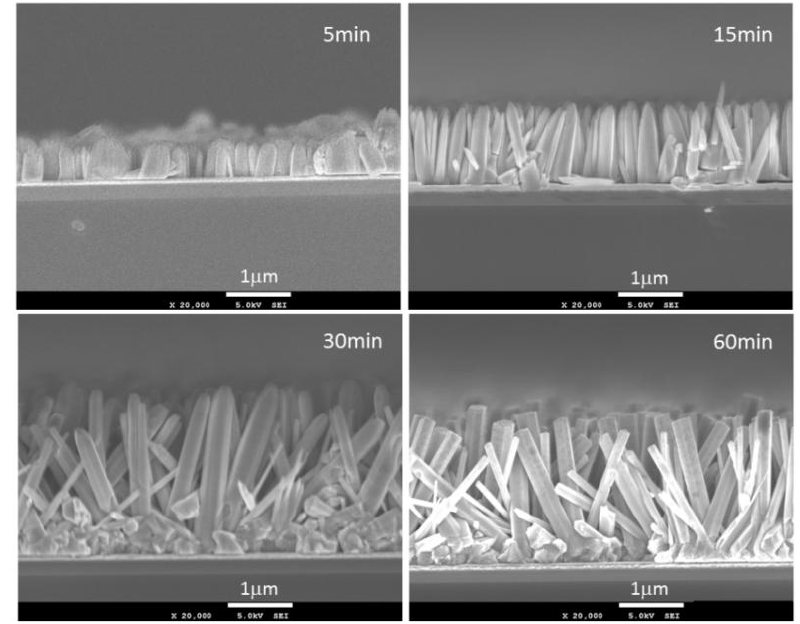
Figure 1. SEM images of ZnO nanostructures after CBD deposition for 5, 15, 30, and 60 min,